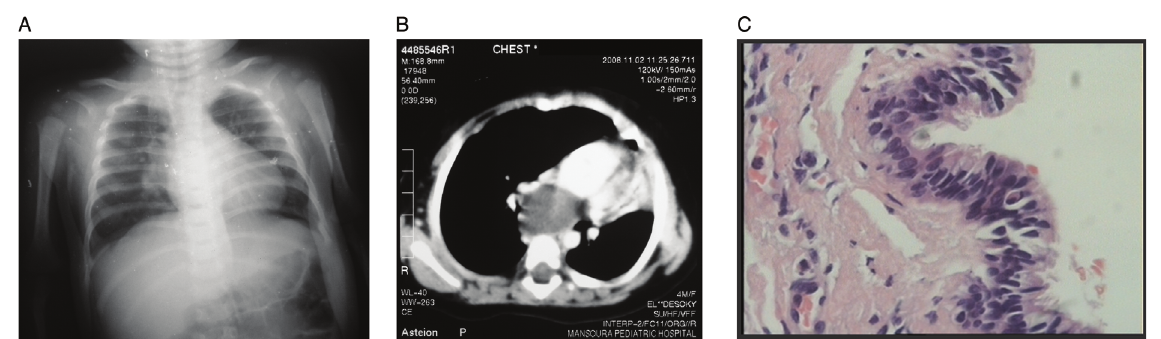
(a) CXR AP shows bilateral overinflation. (b) A CT scan of the chest shows a well-defined, spherical, cystic lesion in the mediastinum. (c) Pathological examination of the wall of the resected cyst shows the respiratory epithelium lining with a pseudostratified columnar epithelium with cilia (H&E stain, ×400). AP, anteroposterior; CT, computed tomography; CXR, chest